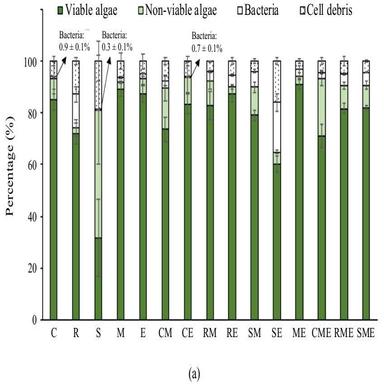
Composition of the PBR cultures (a) and population distribution of the mixed cultures (b) as indicated by flow cytometry: the columns indicate the average values of the results for different cultures after Day 20 (n = 15), with error bars displaying the corresponding standard deviations.